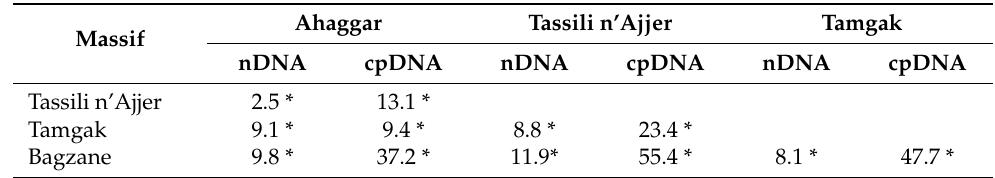
Table 2. Pairwise genetic differentiation ( F ST ; in percent) between populations (massifs) based on nuclear SSR markers (nDNA) and plastid markers (cpDNA).